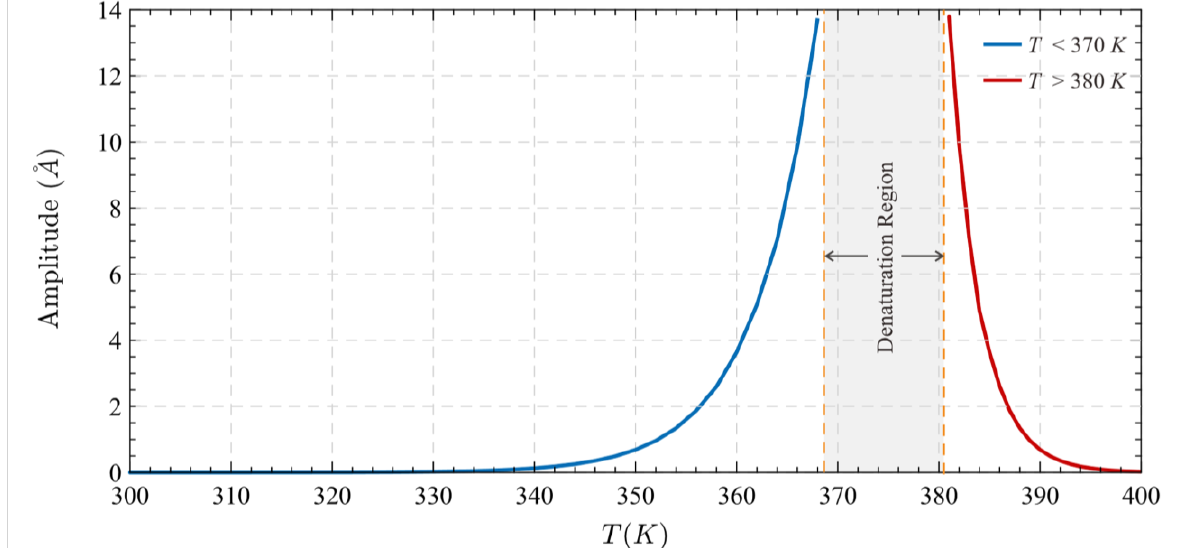
Figure 6. Local denaturation model of the DNA system in the NH